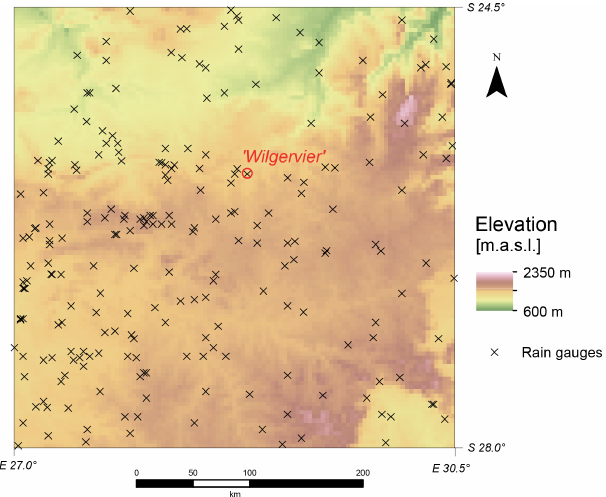
Figure 3. Study area, elevation and location of raingauges.